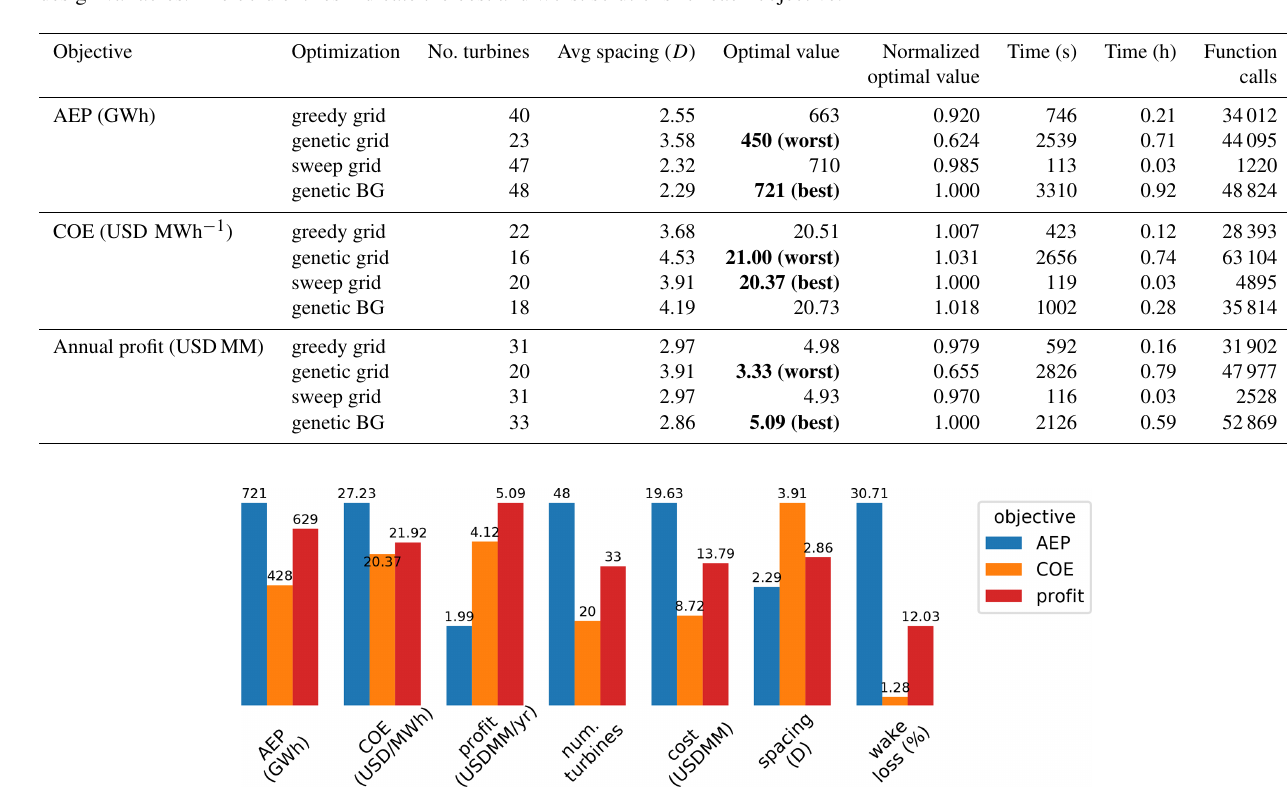
Table 3. Complete optimization results for the large wind power plant with unidirectional wind rose. “BG” indicates the boundary-grid design variables. The bold entries indicate the best and worst solutions for each objective.